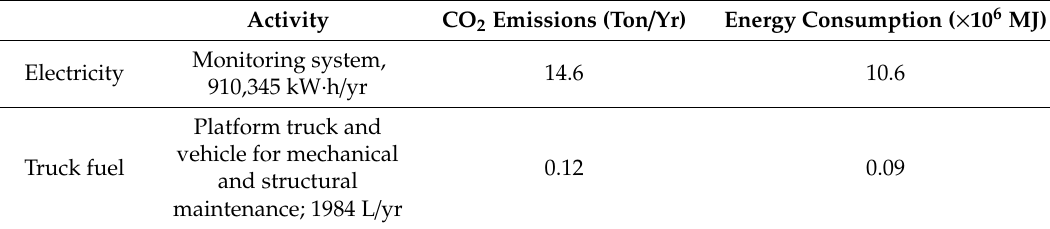
Table 10. Basic annual